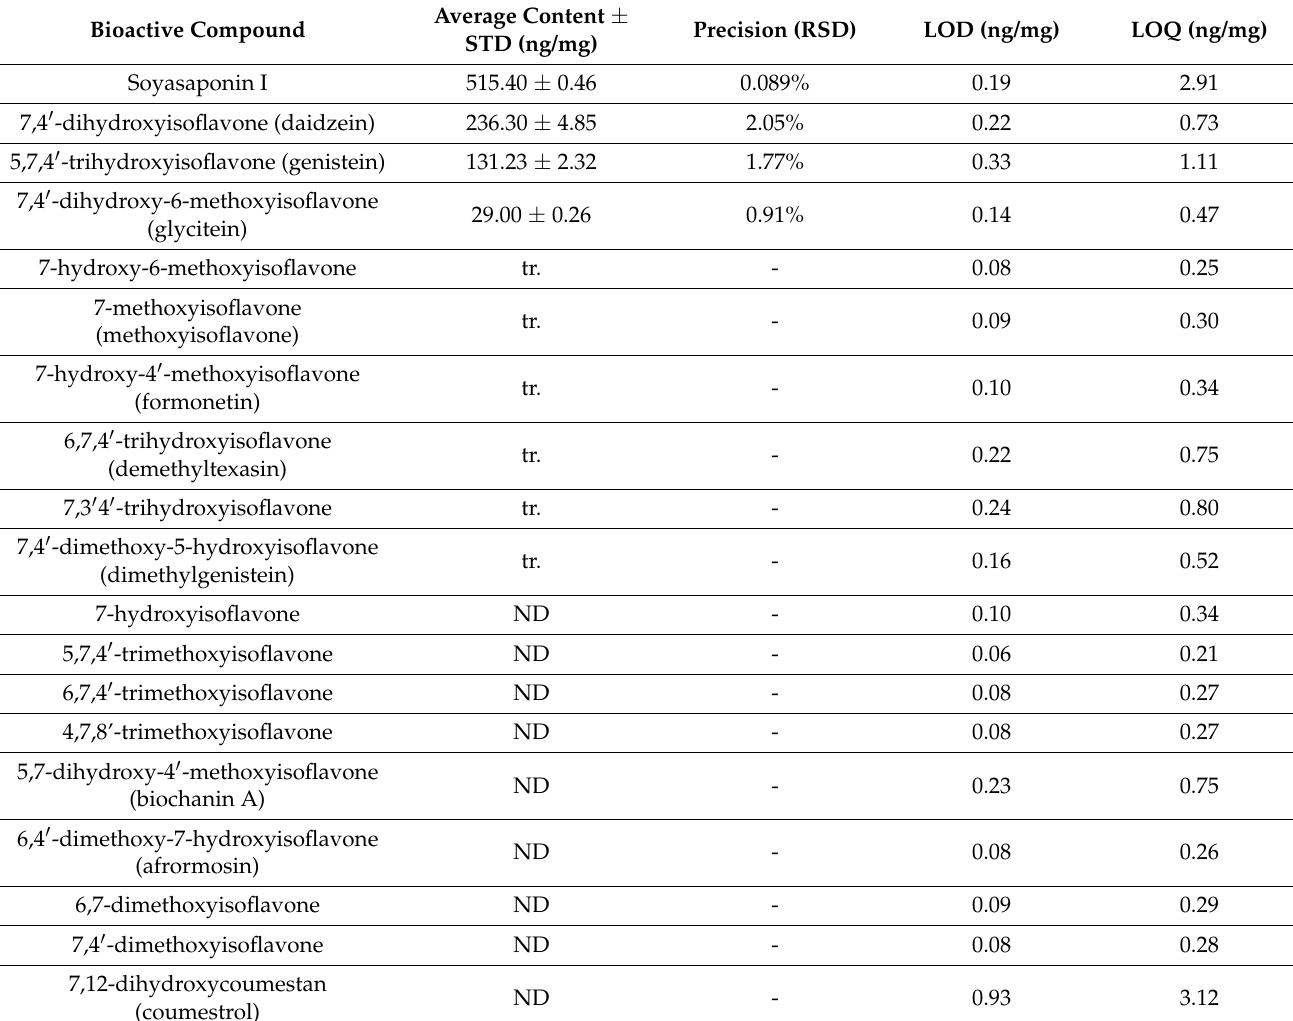
Table 2. Amount of isoflavones and soyasaponins in the methanolic extract of doenjang (MED), assessed by UH- PLC/MS analysis.